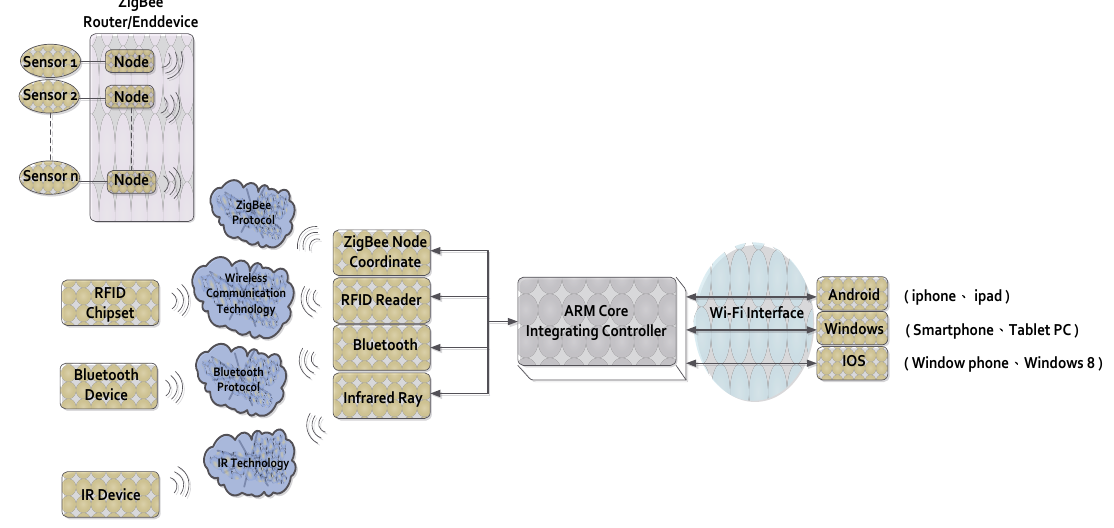
Figure 3. Digital signal convergence technology architecture.